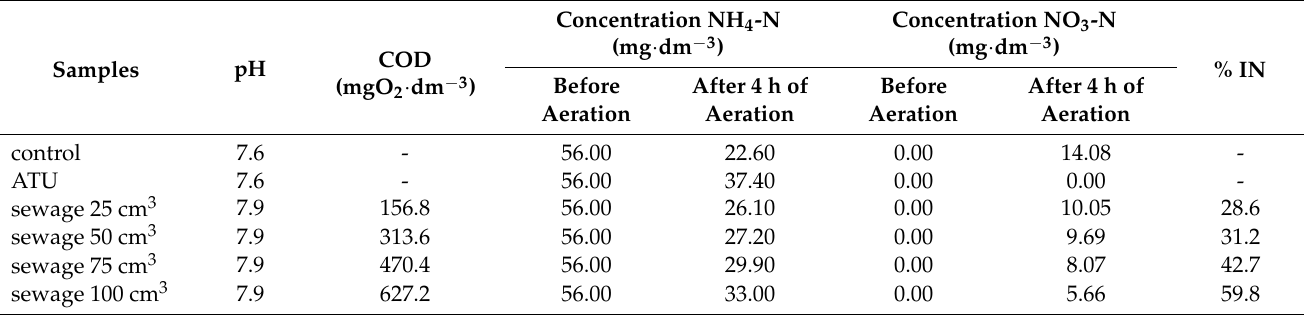
Table 5. Influence of COD of industrial wastewater from styrene–butadiene rubber production on the nitrification inhibition in activated sludge under laboratory